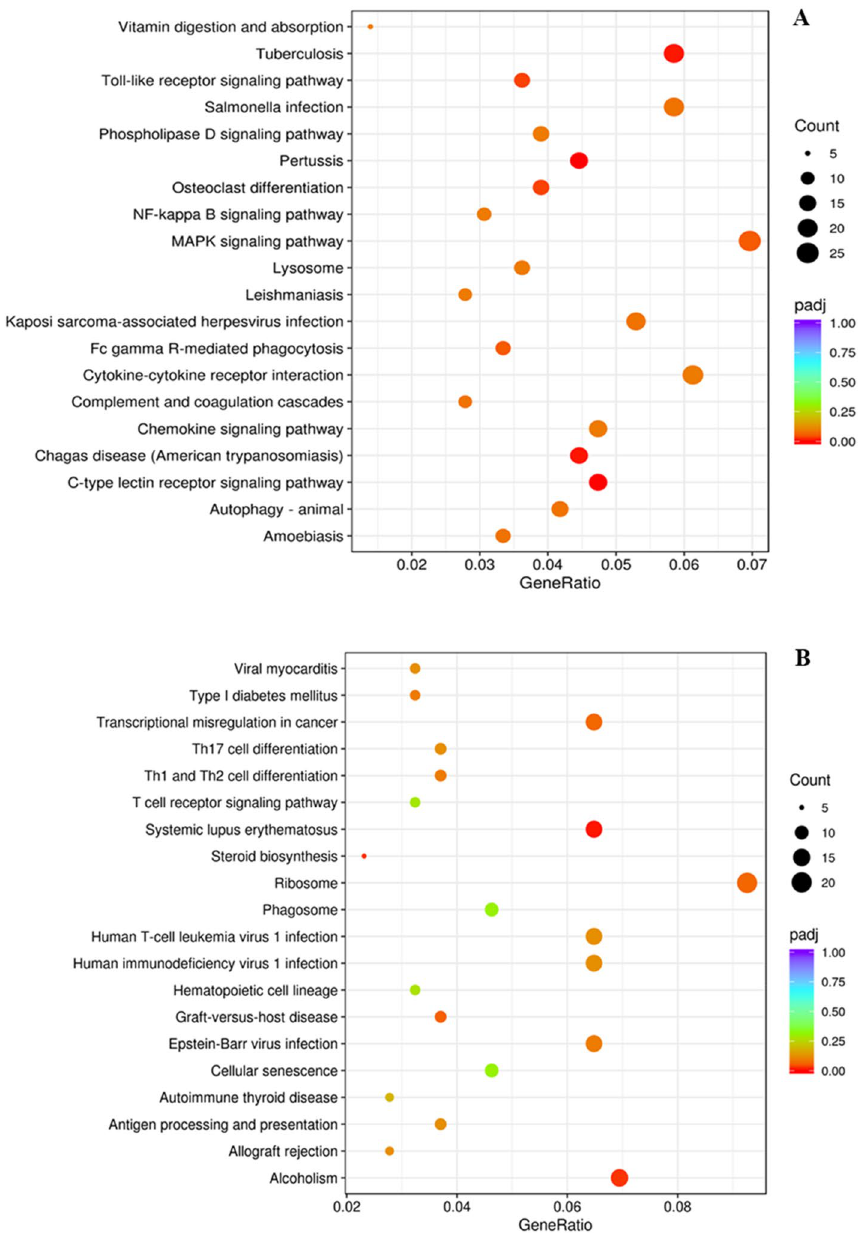
control (not transported but held in pens) versus 180 min (transported for 180 min) stress